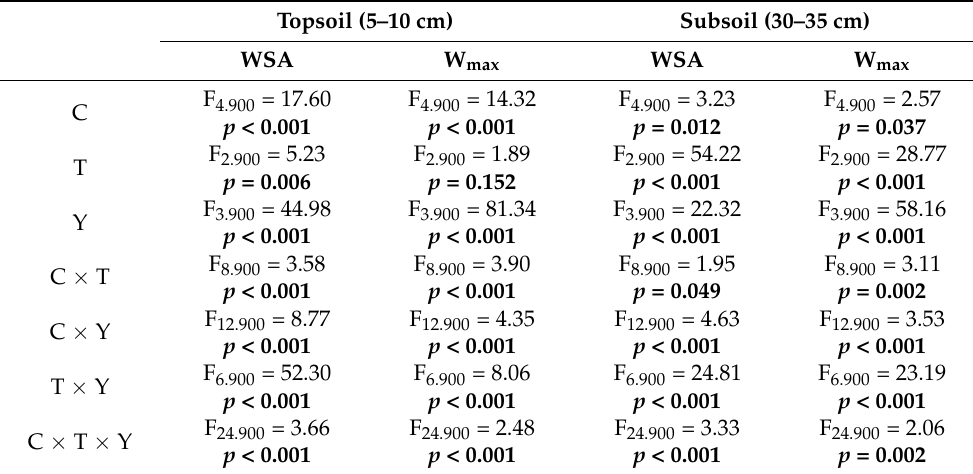
Table 3. Results of the full-factorial analysis of variance from the topsoil (5–10 cm) and subsoil (30–35 cm) between the crops, winter cover crop management systems, yearly differences and their combined interactions of which effects were tested on the soil water-stable aggregate (WSA) content and soil maximum water holding capacity (W max